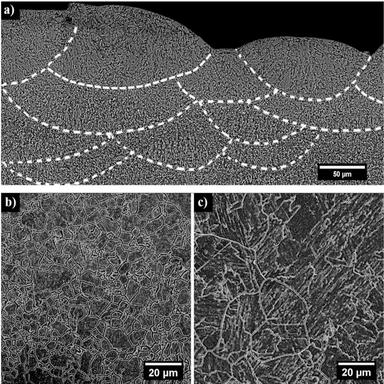
SEM images of 15-5PH in the a) H900-4 h, and annealed conditions (1040 ◦C for 30 min) for b) LPBF sample and c) wrought material after electrochemical etching. The 'fish scale'-like morphology seen in (a) is absent after annealing (b). Microstructure coarsens after annealing (b), but it is still finer than in the conventional material (c).